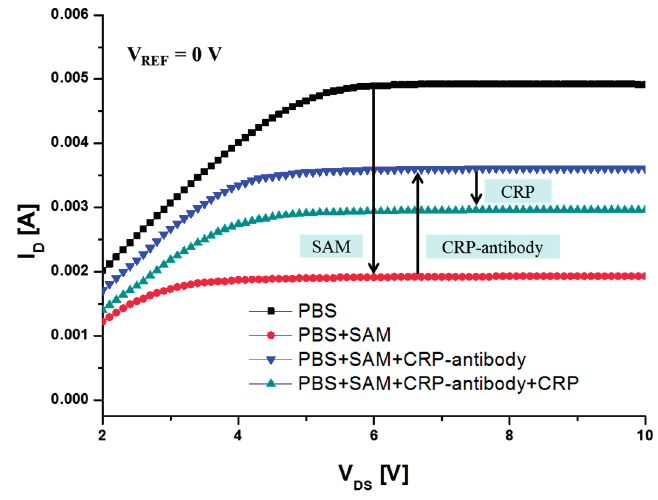
Figure 6. I D - V DS characteristics of the AlGaN/GaN HEMT-based biosensor as a function of interactions among SAM, CRP-antibody, and CRP (1000